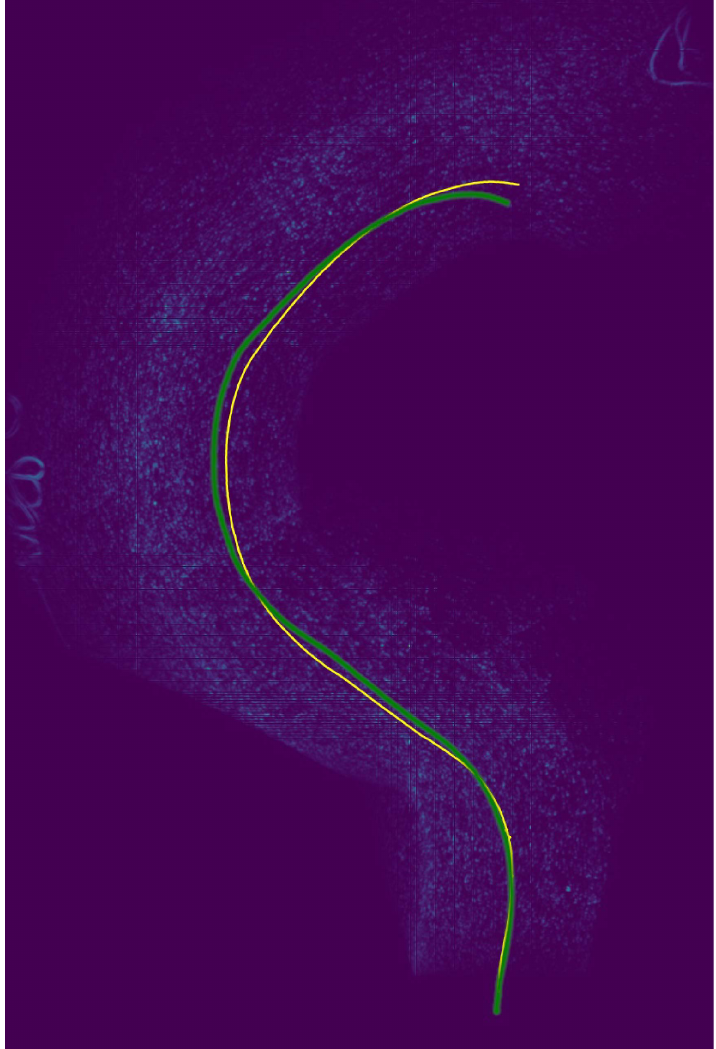
Figure 12. Result of our event camera motion estimation method on a carpeted surface (Green: location of the dolly obtained by ARKit4. Yellow: location of the dolly estimated by the proposed method). Our method was able to estimate motion even on a surface where robust feature point extraction and tracking were